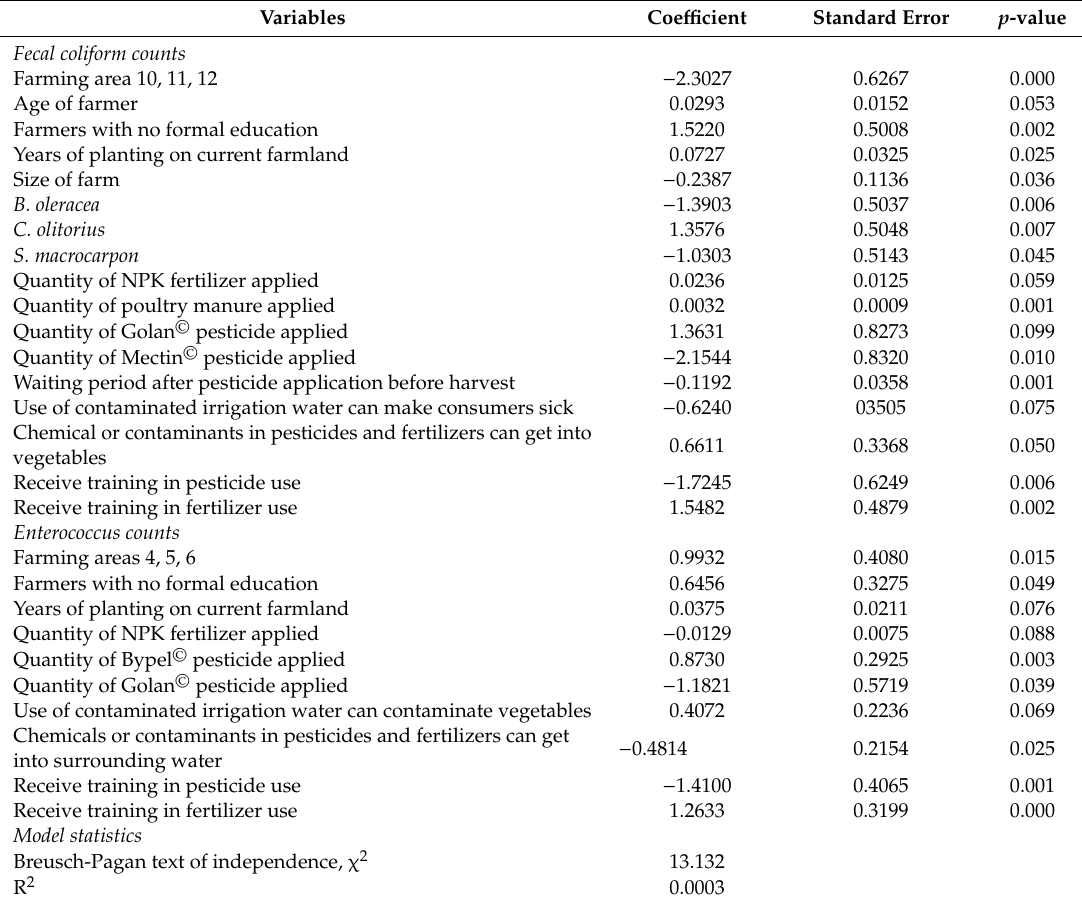
Table 7. Seemingly unrelated regression model of leafy green farming practices on fecal coliform and Enterococcus sp. counts on the vegetables in Accra,